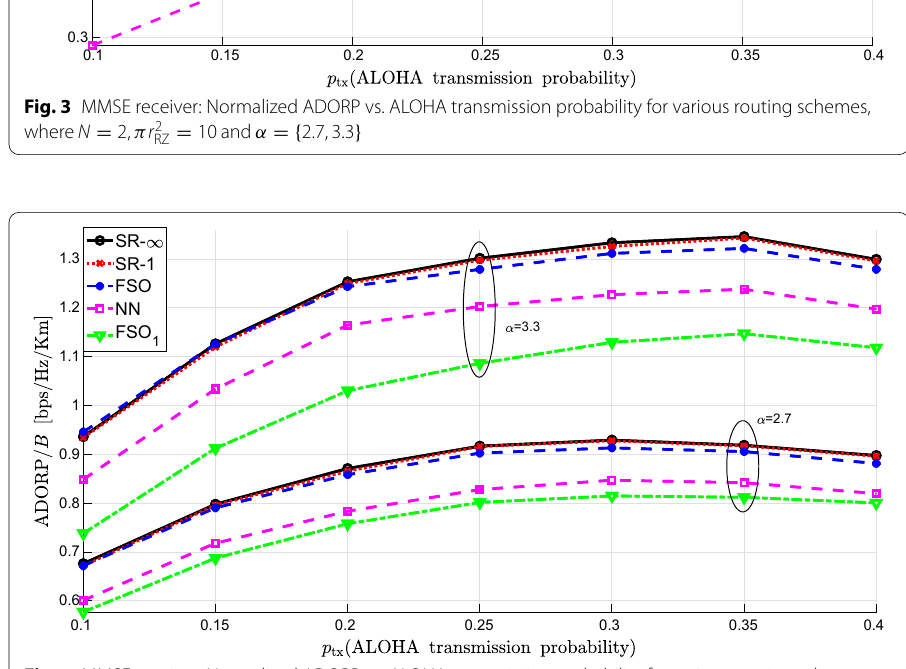
Fig. 4 MMSE receiver: Normalized ADORP vs. ALOHA transmission probability for various routing schemes, where N = 4, π r 2 RZ = 10 and α = { 2.7,3.3